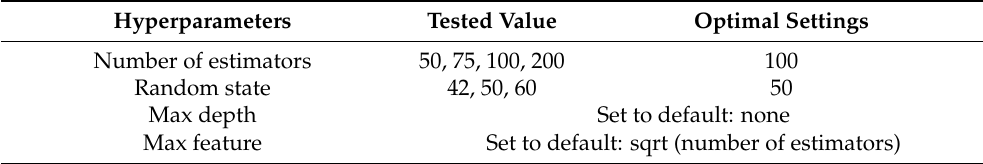
Table 5. Summary of Optimal Hyperparameter Settings for Ensemble Classifier.